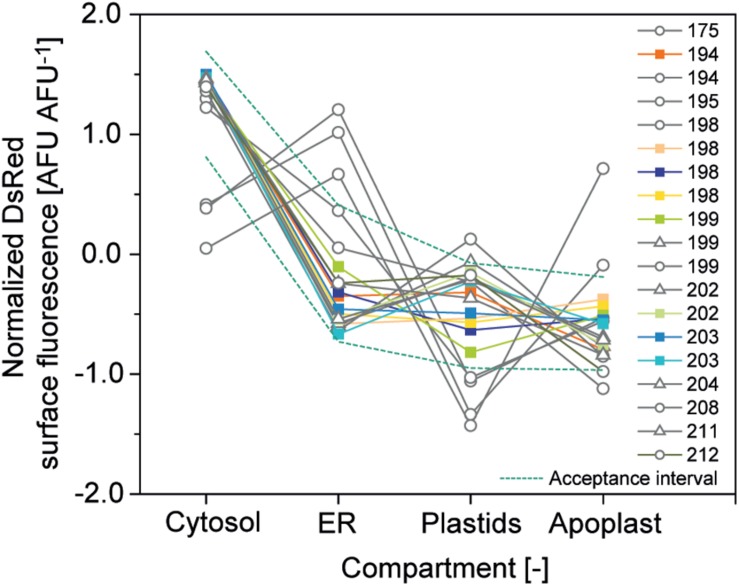
Relative DsRed accumulation in plant cell compartments. Normalized accumulation in cytosol, ER, plastids and apoplast was matched against an acceptance corridor (dotted lines) to identify high-quality cell batches. Batches meeting all quality criteria are represented by colored squares whereas gray circles and triangles indicate runs rejected due to an aberrant accumulation profile in the compartments or due to a CV > 10%, respectively.